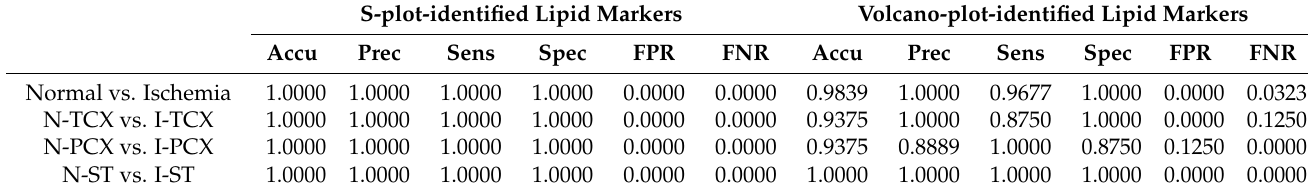
Table 2. Accuracy (Accu), precision (Prec), sensitivity (Sens), specificity (Spec), false positive rate (FPR), and false negative rate (FNR) of validation result using S-plot and volcano-plot-identified lipid markers from normal vs ischemic brain parenchyma (Normal vs. Ischemia), N-TCX vs. I-TCX, N-PCX vs. I-PCX, and N-ST vs. I-ST. See text for details. S-plot-identified Lipid Markers Volcano-plot-identified Lipid